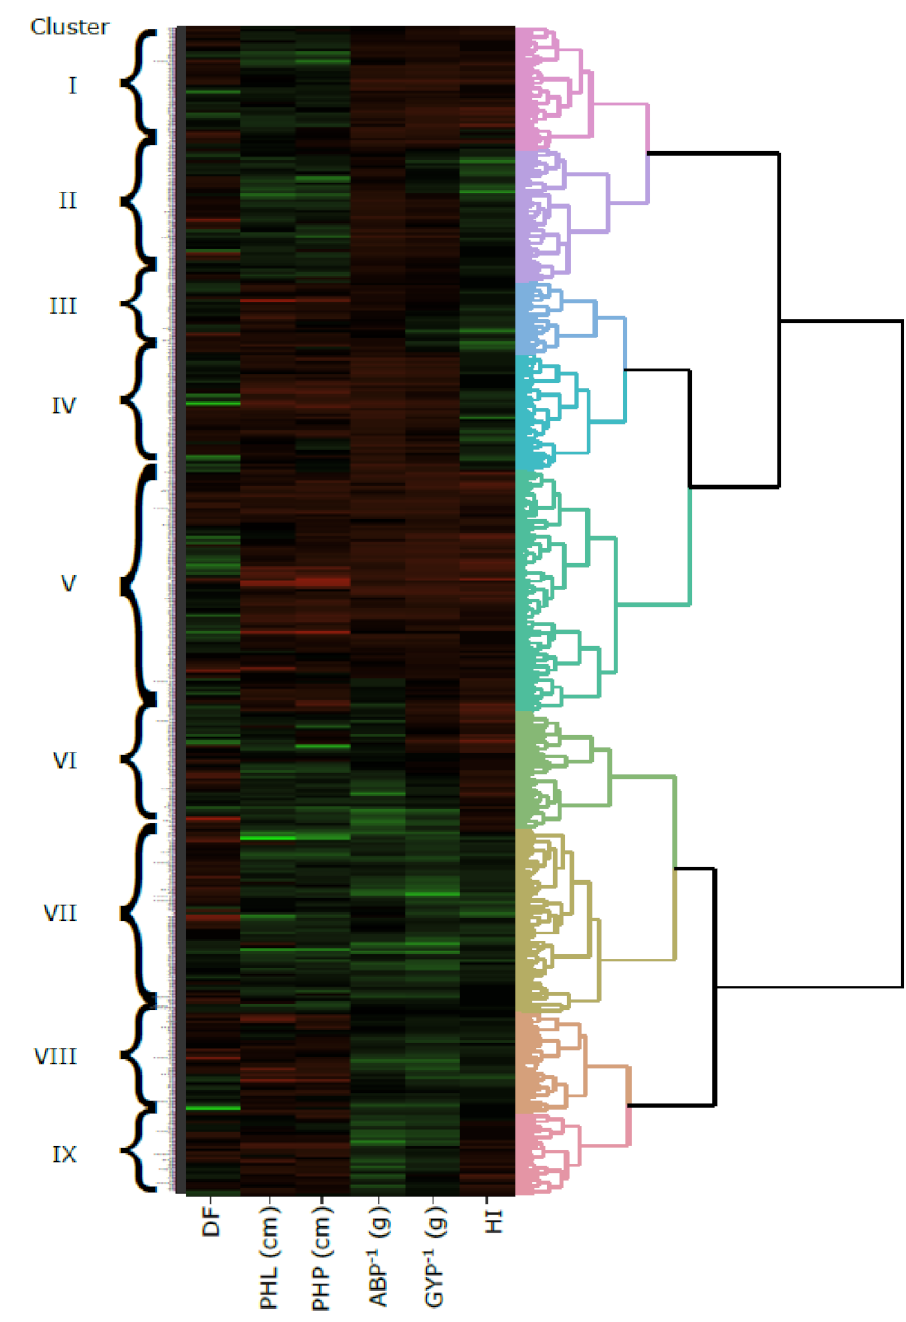
Figure 4. Agglomerative hierarchical cluster analysis (AHC) and heat map of agronomic traits of rice genotypes regarding integrated relative drought stress susceptibility. Note: comparative variable levels correspond to the colour temperature. The colour temperature scheme indicates relative variable levels ranging from minimum (green) to maximum (red) contents of the respective variable. DF = days to flowering; PHL = plant height to leaf; PHP = plant height to panicle; ABP − 1 = above- ground biomass plant − 1 ; GYP − 1 = grain yield plant − 1 . For high resolution illustration, please refer to Figure